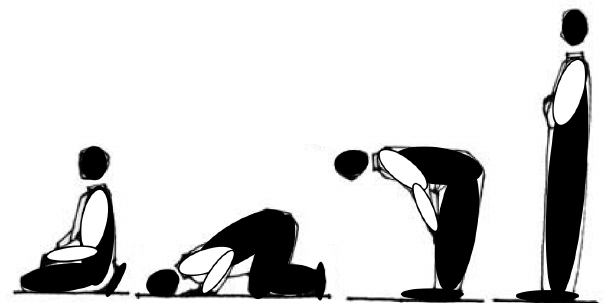
Figure 1. Postures of prayers.